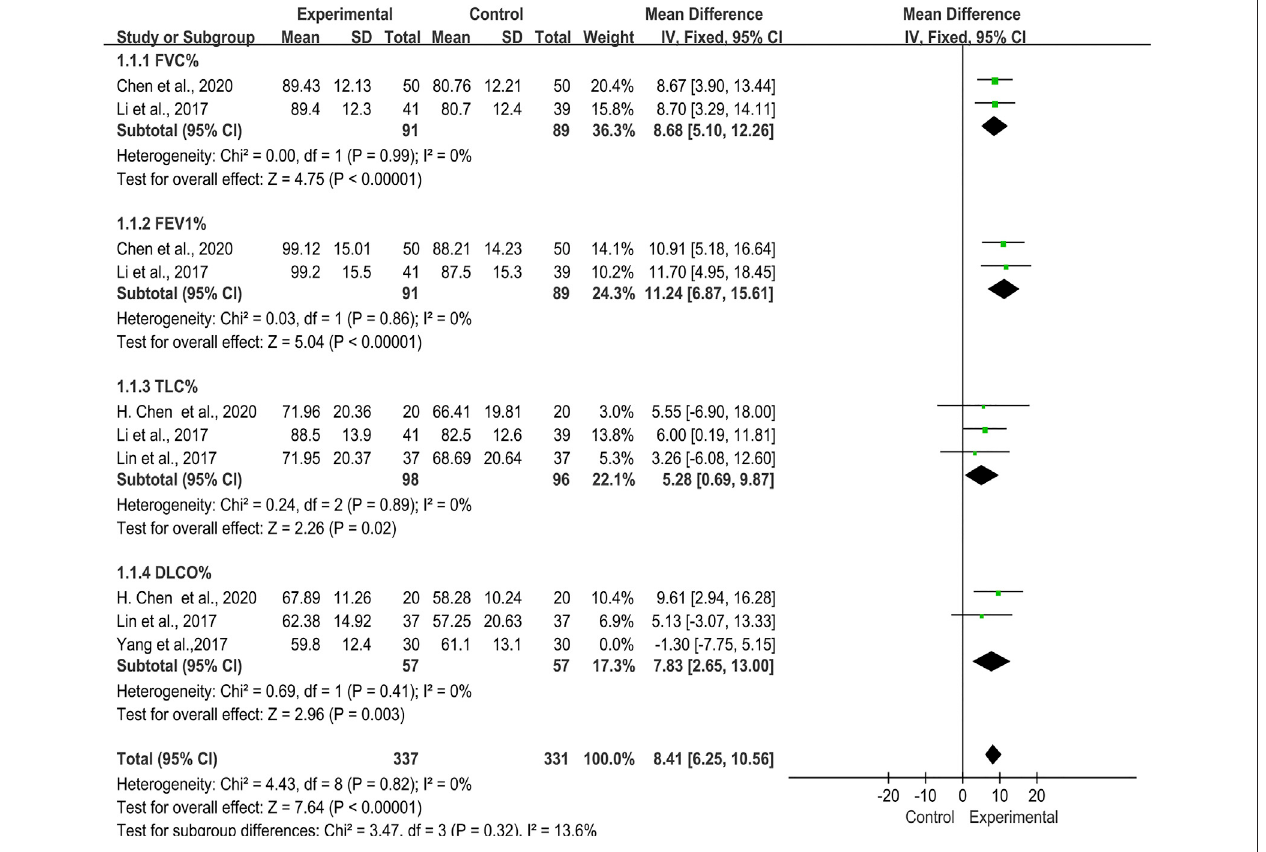
Frontiers in Pharmacology |